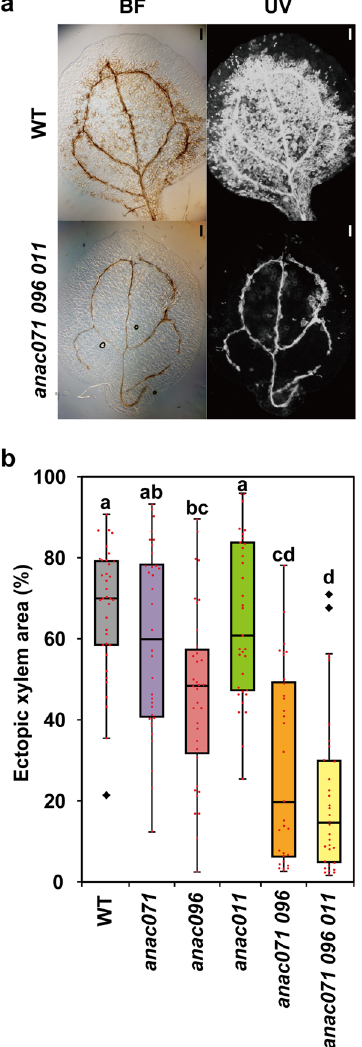
Fig. 5 Morphology of cotyledons under VISUAL assay. a Observation of ectopic xylem vessel elements in WT and anac071 096 011 triple mutant at 4 DOC. Left, bright- fi eld images; right, UV auto fl uorescence images. Scale bars = 200 μ m. b Boxplots showing the percentage of ectopic xylem area in WT and anac mutants ( n = 36 for WT, 34 for anac071 , 35 for anac096 , 33 for anac011 , 31 for anac071 096 , and 33 for anac071 096 011 , respectively). Diamond marks indicate outliers. Statistical analysis was performed using the Steel – Dwass test ( P <